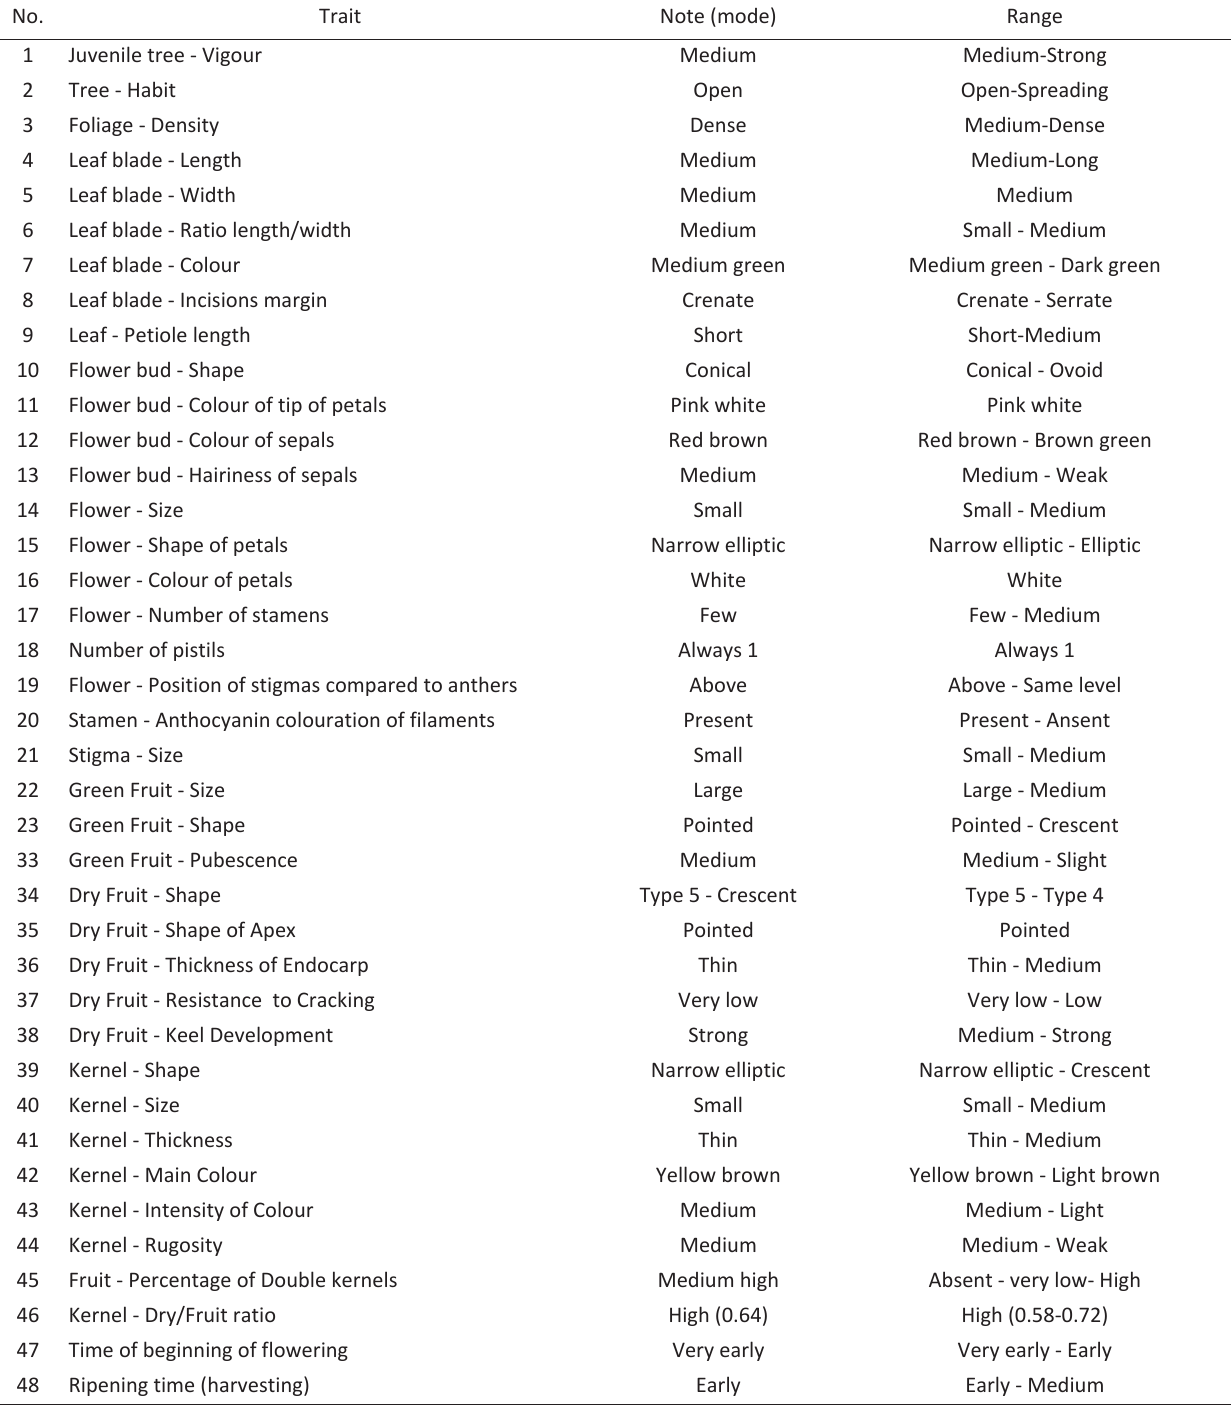
Table 5 - Morphological and phenological characteristics of "Sattarbai" almond type